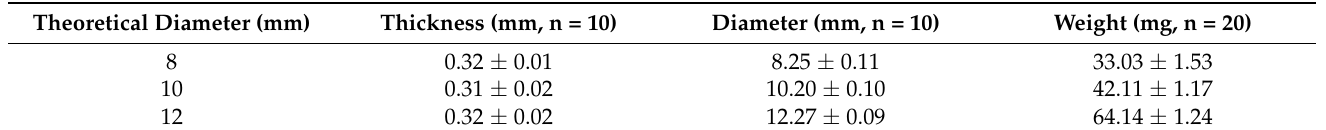
Table 7. The thickness, diameter, weight of different batches of bilayer films.